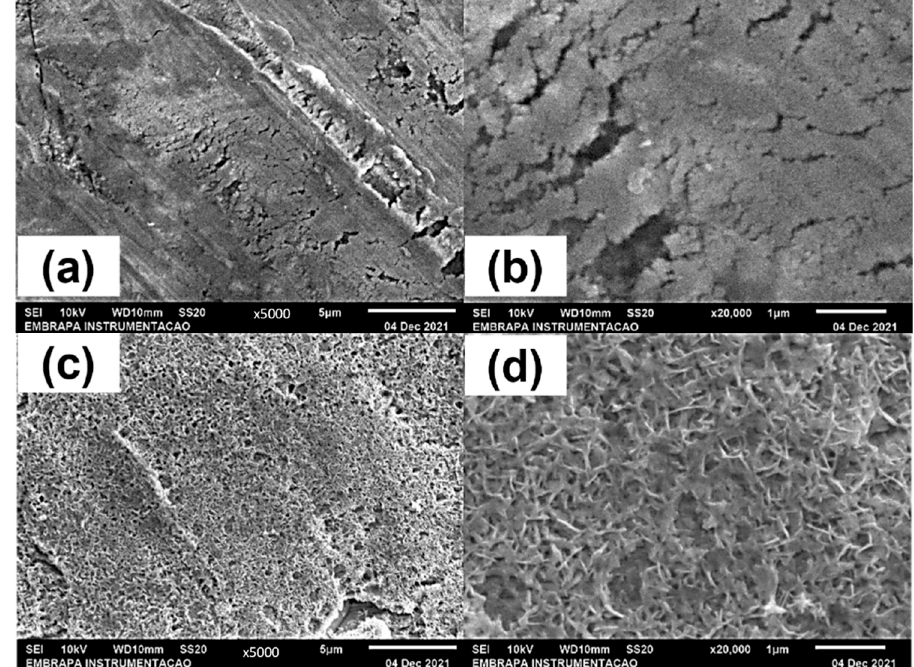
Figure 7. Scanning electron microscope images of the Zn foil before use ( a ) and ( b ), and after solar- assisted charging ( c ) and ( d ) at two different magnifications: the scale bar is 5 µm in ( a ) and ( c ) and 1 µm in ( b ) and ( d ).